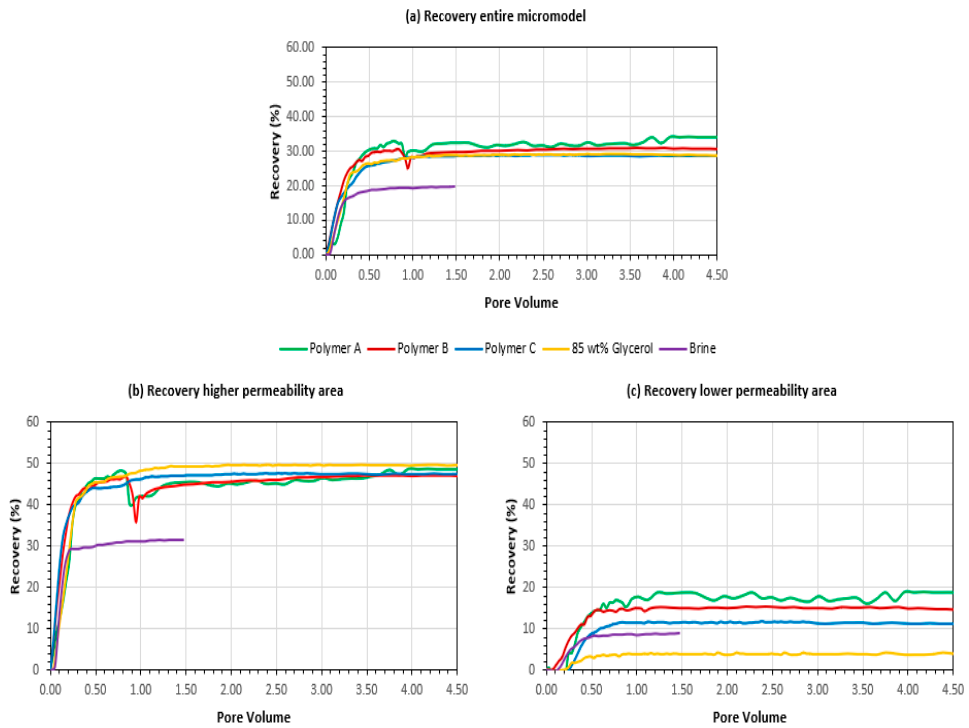
Figure 7. Recoveries obtained in micromodel experiments ( a ) Entire micromodel ( b ) High permeability zone ( c ) Low permeability zone.